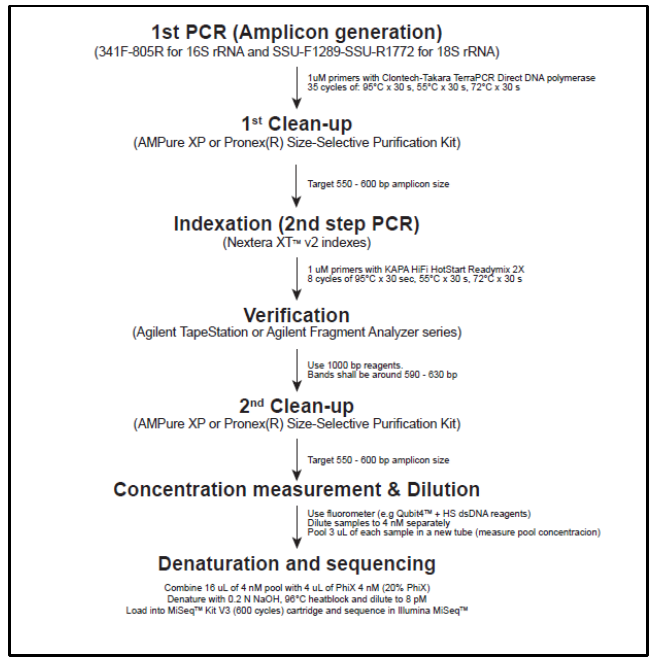
Figure 5. Metabarcoding analysis procedure: Extracted DNA is processed for the first and second PCR followed by sequencing and analysis.